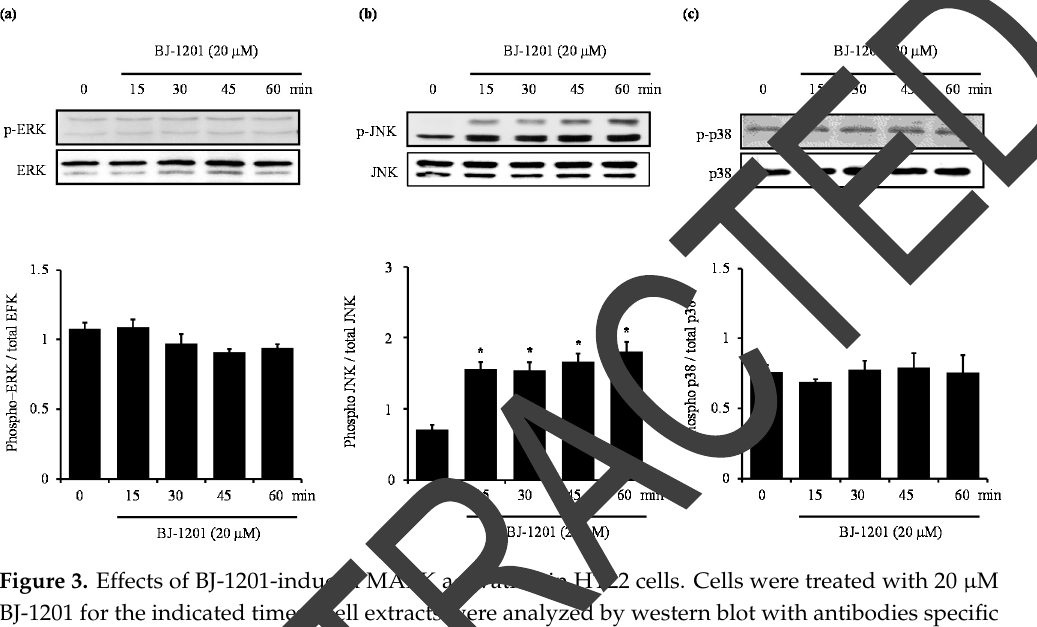
Figure 3. Effects of BJ-1201-induced MAPK activation in HT22 cells. Cells were treated with 20 µ M BJ-1201 for the indicated times. Cell extracts were analyzed by western blot with antibodies specific for ( a ) phosphorylated ERK1/2 (p-ERK); ( b ) phosphorylated JNK (p-JNK); or ( c ) phosphorylated p38 (p-p38). Membranes were stripped and re-probed for the total form of each MAPK as a control, and representative blots of three independent experiments are shown. Each data represents the mean ± S.D. of three independent experiments are shown. * p < 0.05 compared with control group.